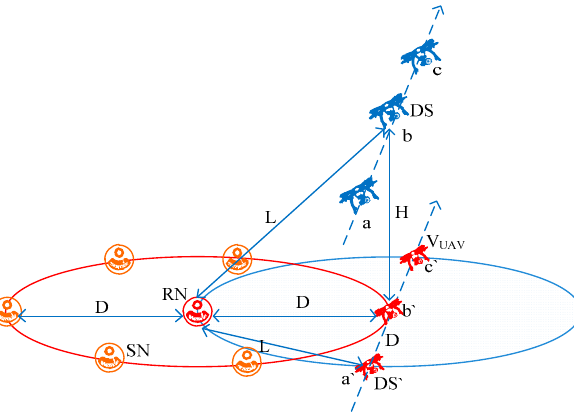
Figure 7. Data transmission from the SN to the mobile DS mounted on a unmanned aerial vehicle